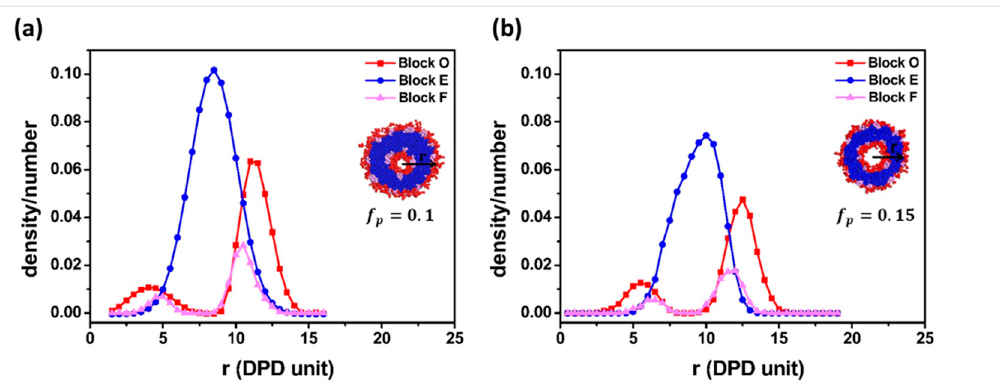
Figure 4. Composition profiles of vesicles formed in different polymer concentrations: ( a ) 𝑓 𝑝 =0.1; ( b ) 𝑓 𝑝 =0.15.